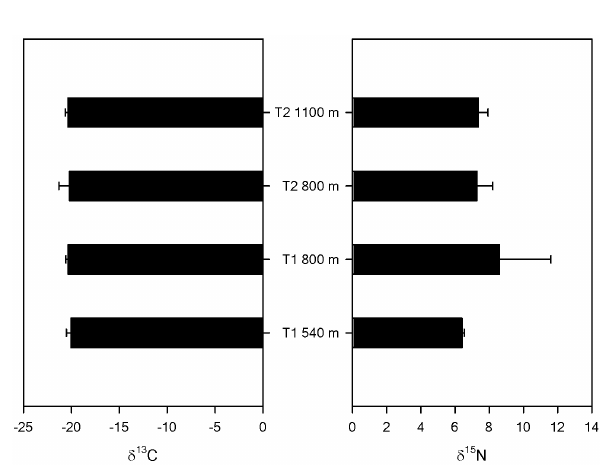
Fig. B1. Mean ( ± standard deviation) natural stable-isotope signa- tures of sediment organic matter (00–05cm) at the four experimen- tal stations. Data is derived from 3 push cores taken at each